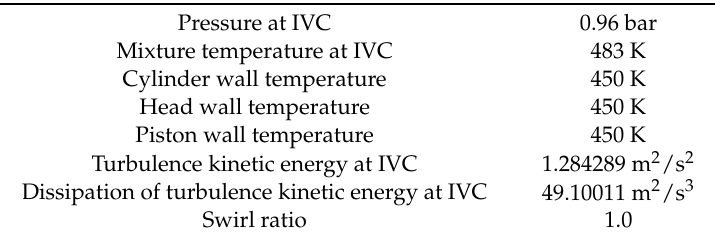
Table 2. Initial and boundary